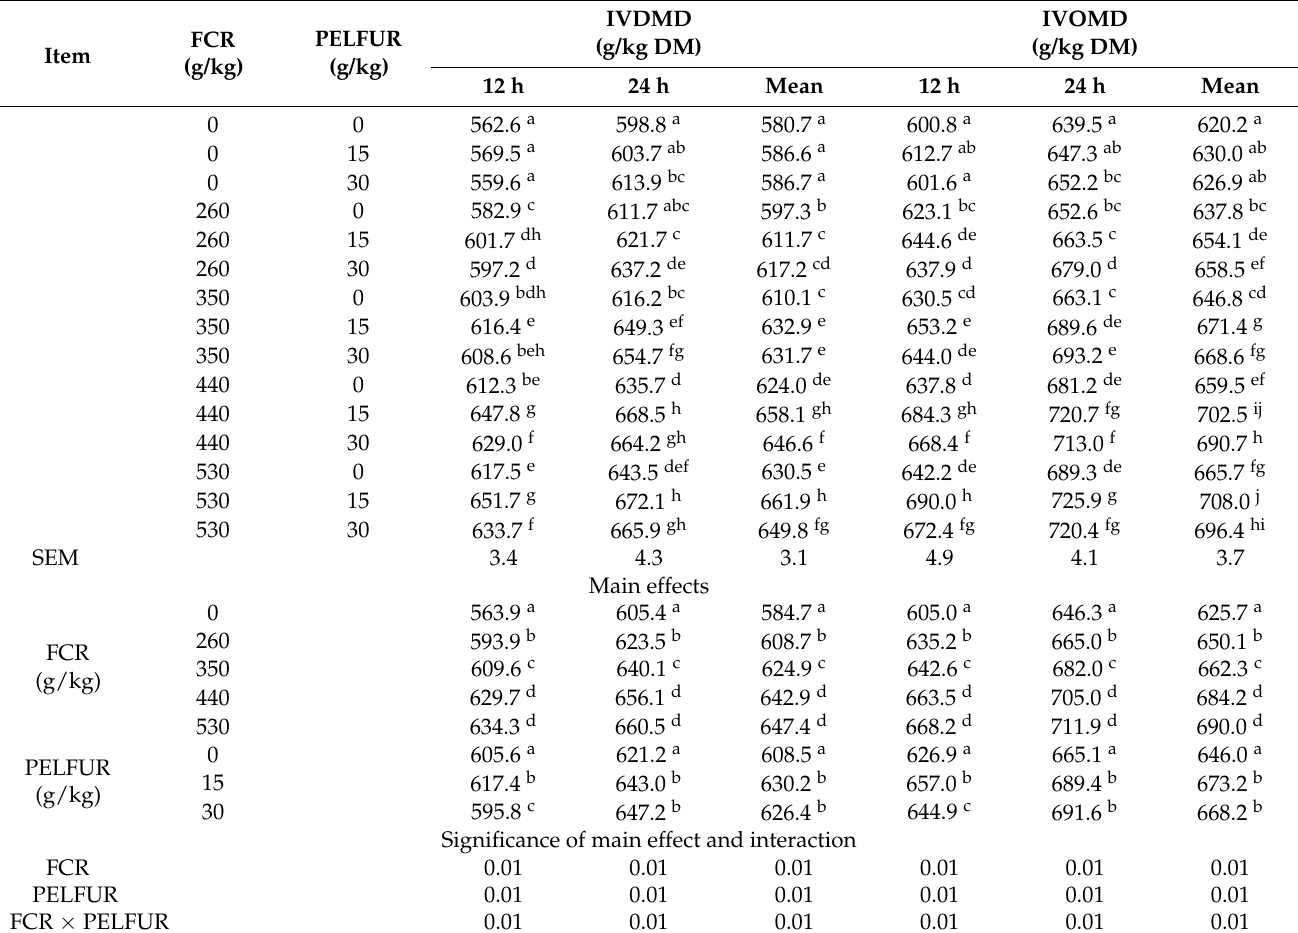
Table 4. The effect of fresh cassava root (FCR) with pellets containing high sulfur (PELFUR) on the in vitro digestibility of